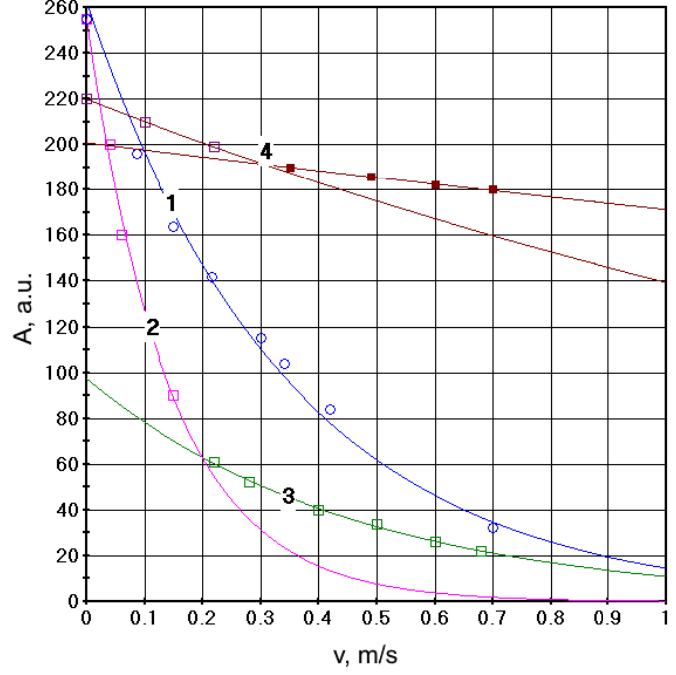
Figure 6. PMR-signal SE amplitudes A (a.u.) from flow rate υ (m/s). Curves: 1 — 100% water, 2 — 90% water in emulsion ( υ < 0.2 m/s), 3 — 90% water in emulsion ( υ > 0.2 m/s), 4 — 25% water in emulsion ( υ < 0.3 m/s), and 5 — oil ( υ > 0.3 m/s).